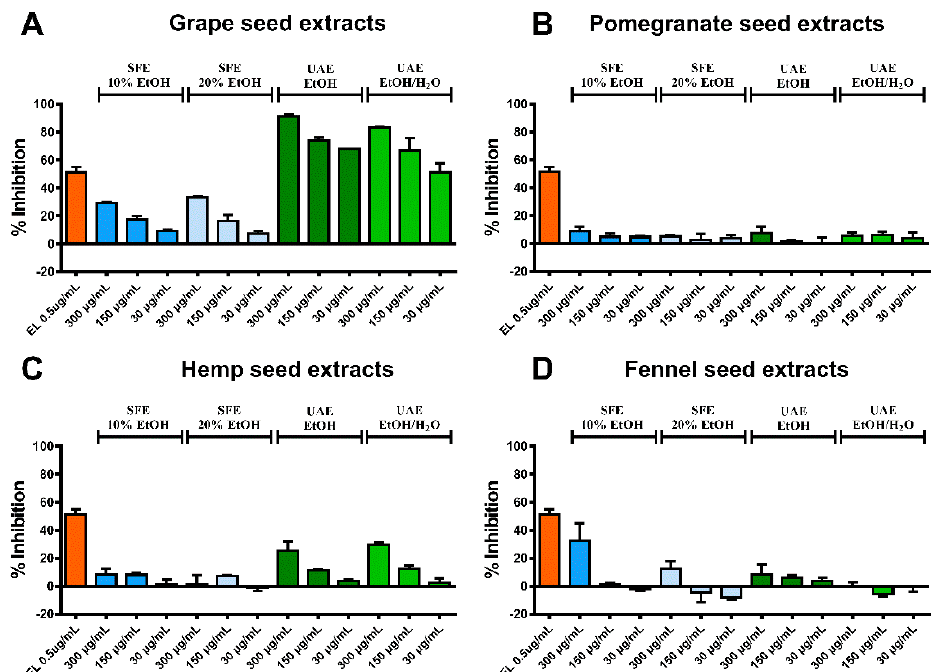
Figure 2. Results of the elastase activity assay. The percentage of elastase enzyme inhibition (%) is presented for the produced extracts from ( A ) grape seeds, ( B ) pomegranate seeds, ( C ) hemp seed and ( D ) fennel seeds. Elastatinal (EL) was used as positive control.